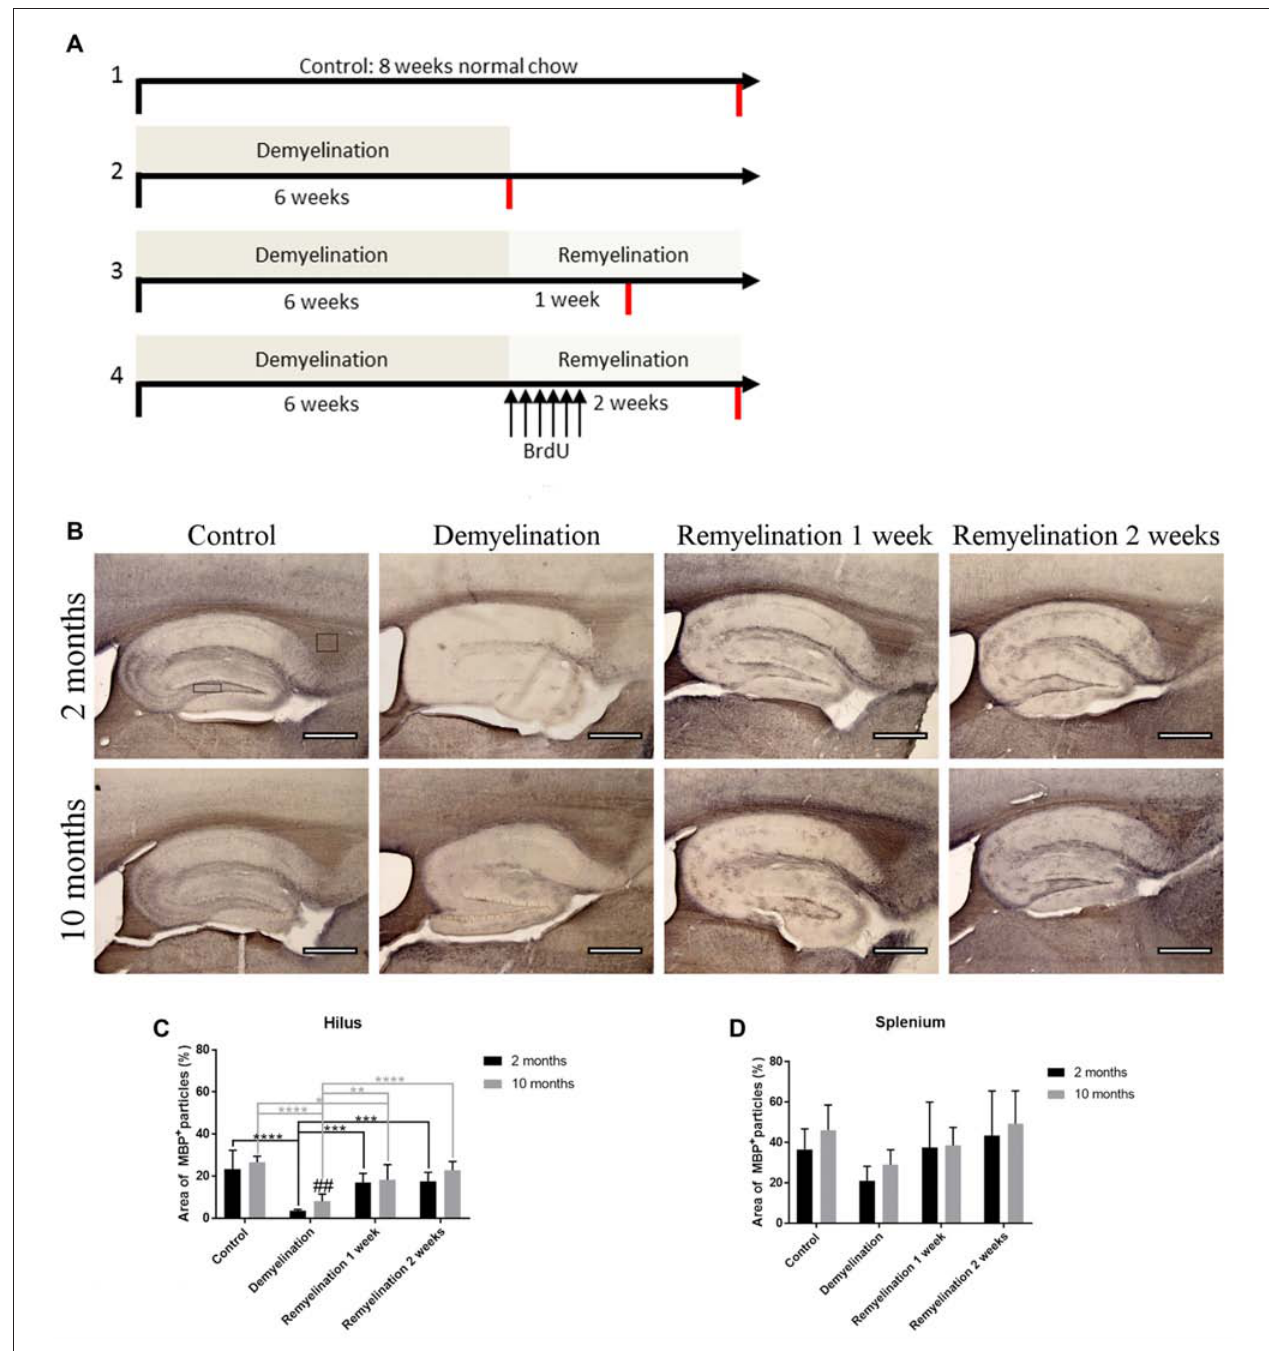
FIGURE 1 | Experimental design and analysis of de- and remyelination. (A) Overview of the different treatment groups and the timeline of the experiment. All four treatment groups (controls, demyelination, 1 week remyelination and 2 weeks remyelination) were compared at two different ages: young (starting in 2-month-old animals) and middle-aged (starting in 10-month-old animals). To analyze proliferation and subsequent survival of microglia during remyelination, controls and the remyelination groups received six BrdU injections starting as soon as the demyelination-inducing cuprizone treatment was stopped. The red lines indicate the time of tissue collection. (B) Myelination was analyzed using staining for myelin basic protein (MBP). The analyzed regions of interest are indicated by rectangles. (C) In the hilus of the dorsal hippocampal dentate gyrus (DG), both age groups were significantly demyelinated, followed by remyelination beginning 1 week after the end of the cuprizone treatment. After six weeks of cuprizone treatment, demyelination was slightly, but significantly, more severe in the young group. (D) In the splenium of the corpus callosum (CC), the observed myelin changes during de- and remyelination were less pronounced. Values are shown as means + standard deviation (SD n = 6 per group). Statistical significance was evaluated using a two-way ANOVA followed by a Tukey’s post hoc test. The p -values are indicated in the graphs: treatment effects within the same age group: ∗ p < 0.05, ∗∗ p < 0.01, ∗∗∗ p < 0.001 and ∗∗∗∗ p < 0.0001, age-related differences: ## p < 0.01. Bars: (B) 500 µ m.